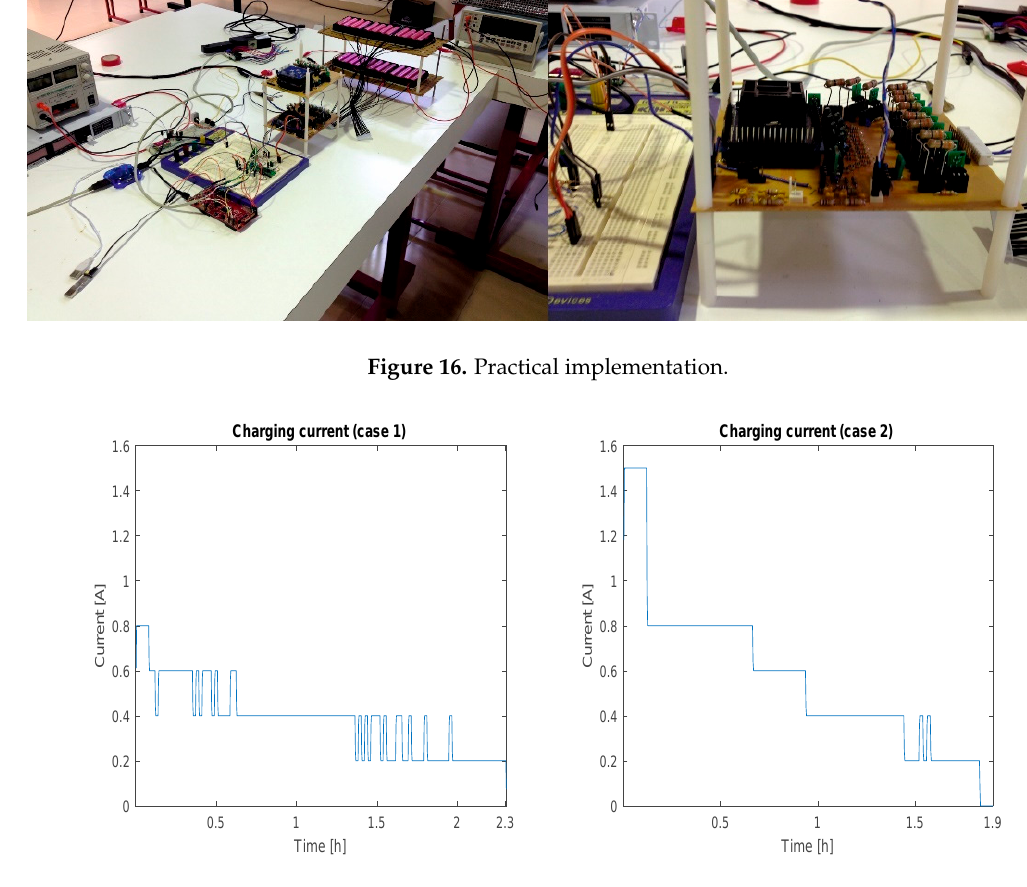
Figure 17. Current profile during charging.